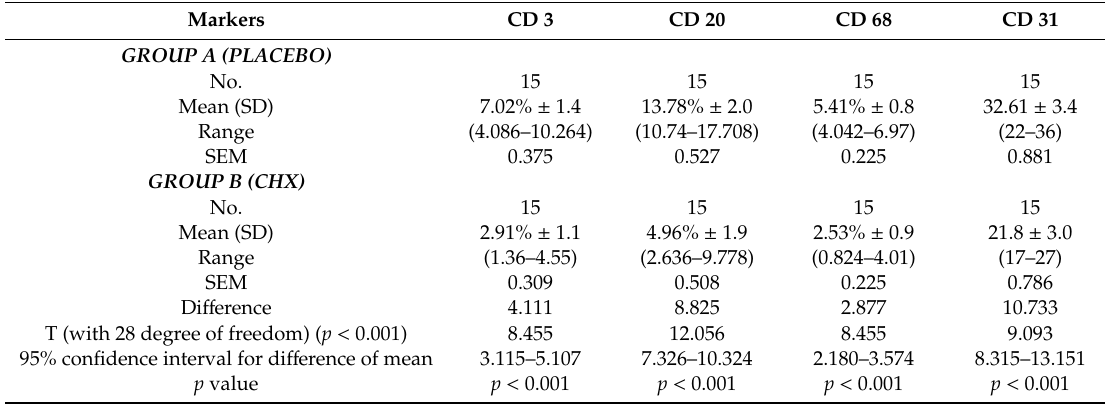
Table 3. Inflammatory infiltrate at second surgical stage (T1) expressed as mean and standard deviation and analysis of Variance. Statistical significant di ff erences between single markers were found ( p < 0.001). Group A: placebo samples. Group B: Chlorhexidine (CHX) samples.